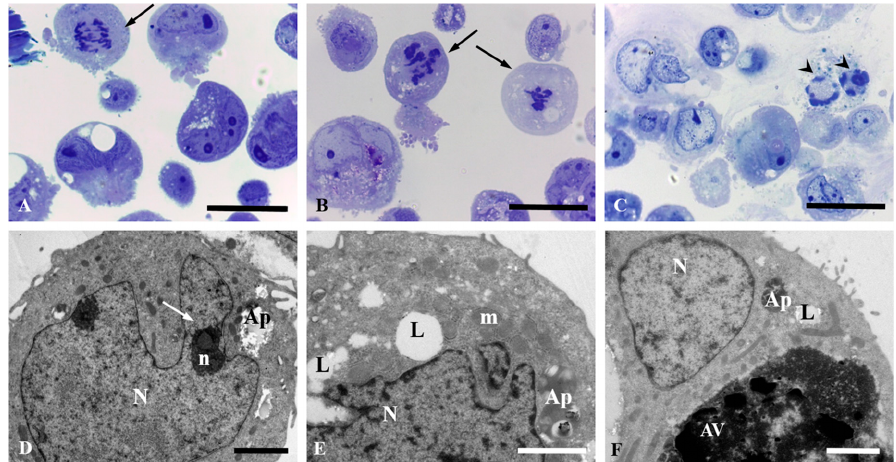
Figure 4. Morphology of Caco-2cells after 24 h of exposure to the stilbene extract (45%) observed by light microscopy ( A , B , C , bars = 25 μ m) and electron microscopy ( D , E , F , bars = 2 μ m). Unexposed control cultures ( A , D ), and Caco-2 cells exposed to 13.9 μ g/mL of the extract (B, E ) and 27.88 μ g/mL of the extract ( C , F ). ( A ) Unexposed cells undergoing mitotic processes (black arrow). ( B ) Cells undergoing aberrant mitosis (black arrow). ( C ) Cells showing apoptotic nuclei condensation (arrow head). ( D ) Unexposed cells showing normal nucleus with an irregular surface (N), nucleolus (n) with large fibrillar center (white arrow), and autophagosomes (Ap) in the cytoplasm. ( E ) Damaged nucleus and mitochondria are observed as well as big lipid drops. Autophagosomes (Ap) evidenced degenerative process. ( F ) Lipid drops (L), autophagosomes (Ap), and autophagic vacuoles (AV) are shown.